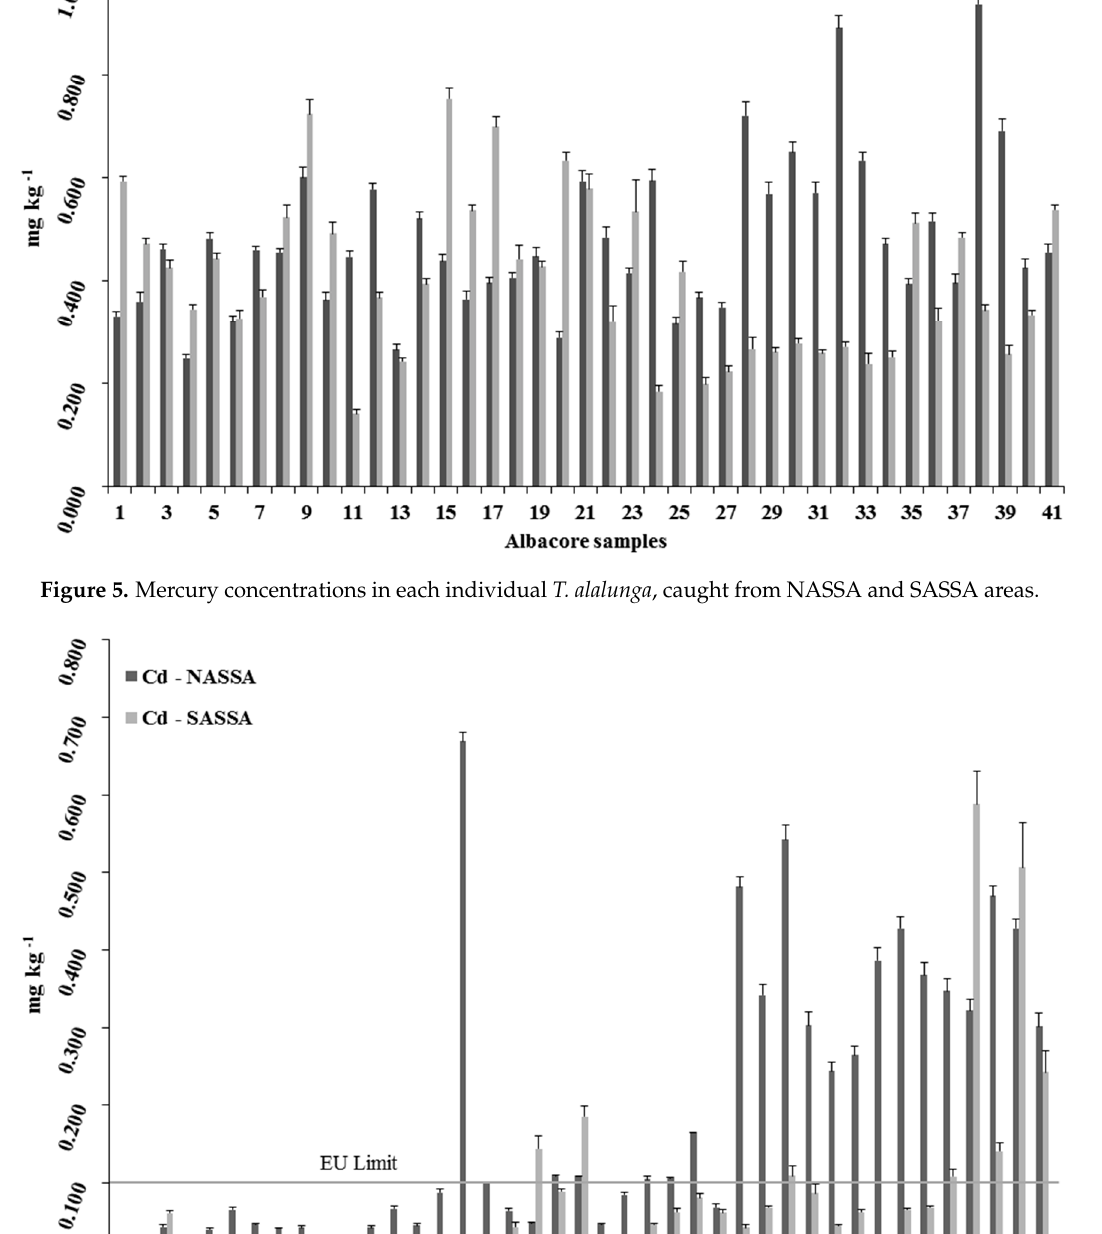
Figure 7. Lead concentrations in each individual T. alalunga , caught from NASSA and SASSA areas.